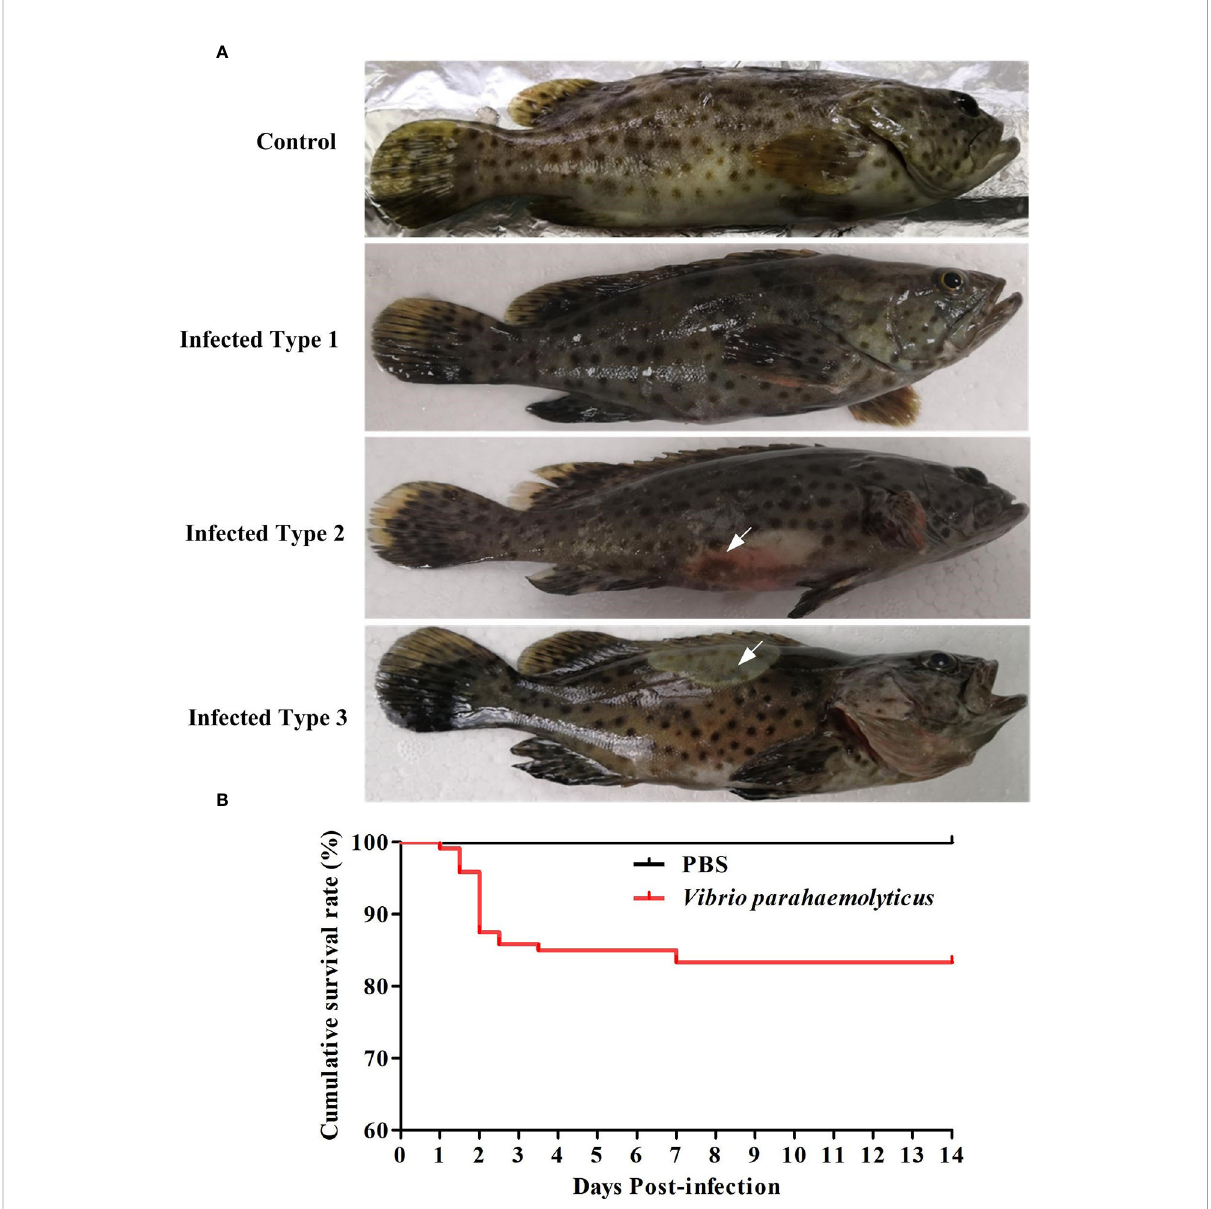
FIGURE 1 Clinicalsymptomsandcumulative survival of E. coioides challengedwith V. parahaemolyticus . (A) Theclinicalsymptomsof E. coioides challengedwith V. parahaemolyticus . Infected Type 1: fi shbody colorturnedblack;InfectedType2:theswellingbleedingsymptomwasfoundnearabdominal cloaca(white arrownotation);InfectedType3:therewaswhitepatchesnearthedorsal fi n(whitearrownotation). (B) The cumulativesurvivalof E. coioides infected with V.parahaemolyticus throughout twoweeks.n=60biologically